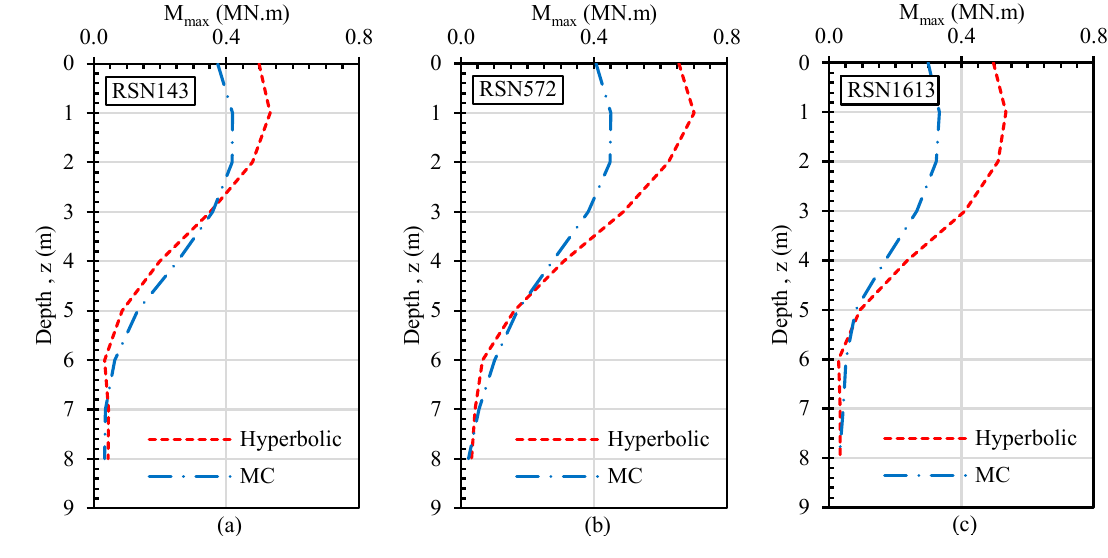
Figure 14. Maximum bending moment vs. depth using Hyperbolic and MC models ( a ) RSN143, ( b )